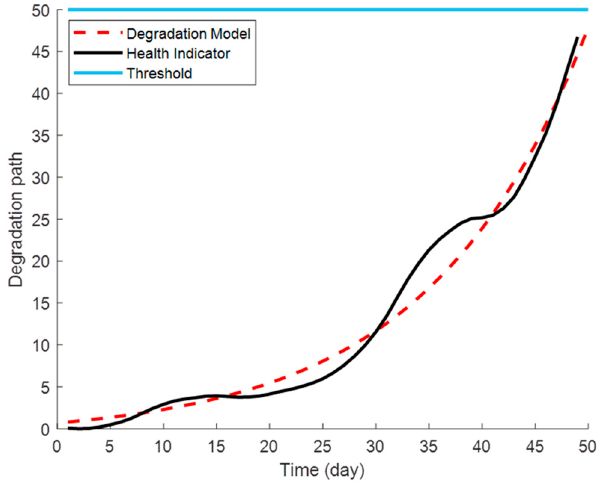
Figure 9. Degradation trajectory of HSSB and prediction trajectory of the exponential degradation model.